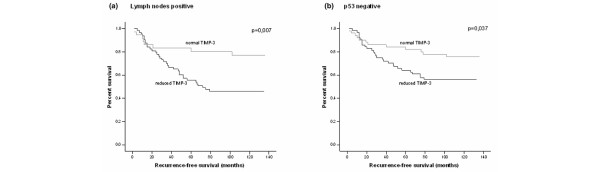
The prognostic significance of TIMP-3 protein expression in the LN+ and p53- patient subgroups. The graphs show the impact of tissue inhibitor of metalloproteinases (TIMP)-3 on the recurrence-free survival of the lymph-node (LN)-positive (a) and mutant-p53-negative (b) patients (log-rank test).